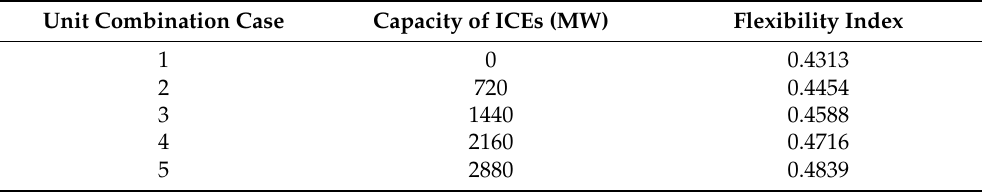
Table 2. Relationship between ICE capacity and flexibility index under different unit combinations.